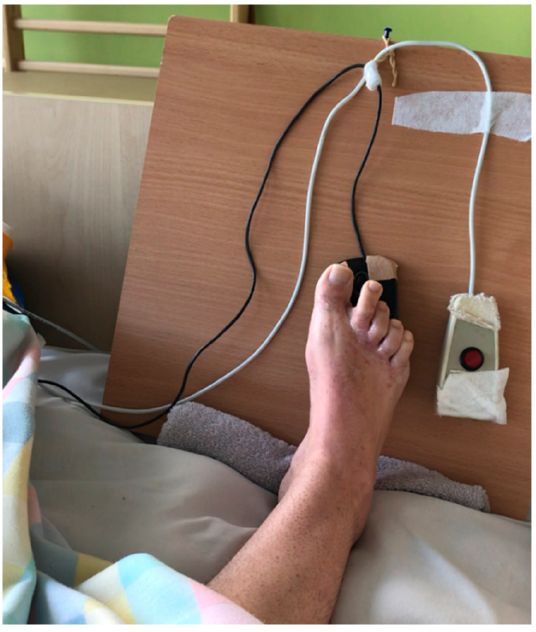
Figure 2. Patient’s ability to communicate by using the computer.